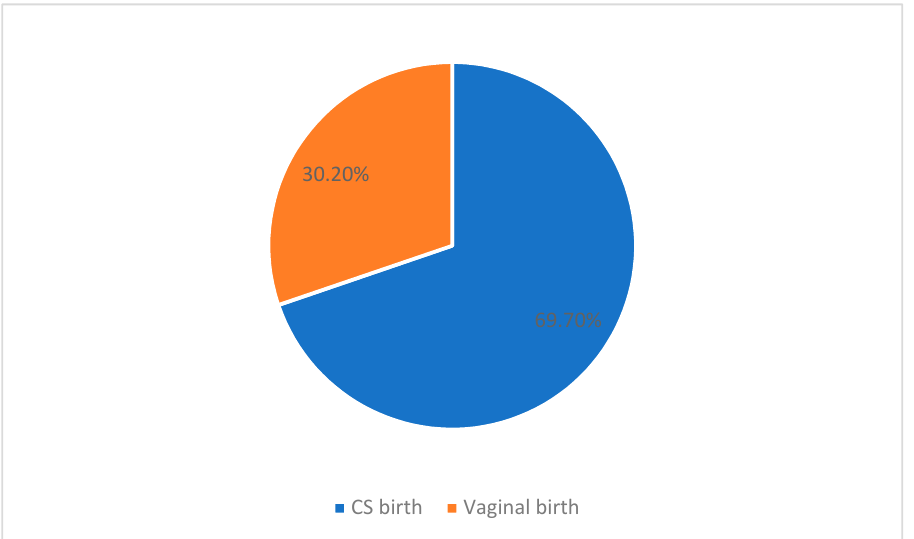
Figure 1. Rate of cesarean section in the study population. p < 0.001.